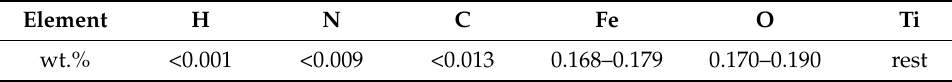
Table 1. The elemental composition of the substrate material, wt.%.